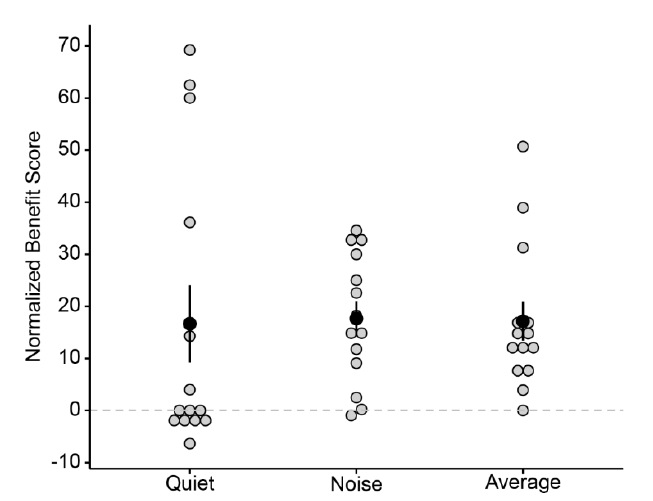
Figure 5. Normalized benefit score received from an additional HA in the non-implanted ear for lexical tone recognition in quiet (left column), in noise (middle column), and the average across the two listening conditions (right column).